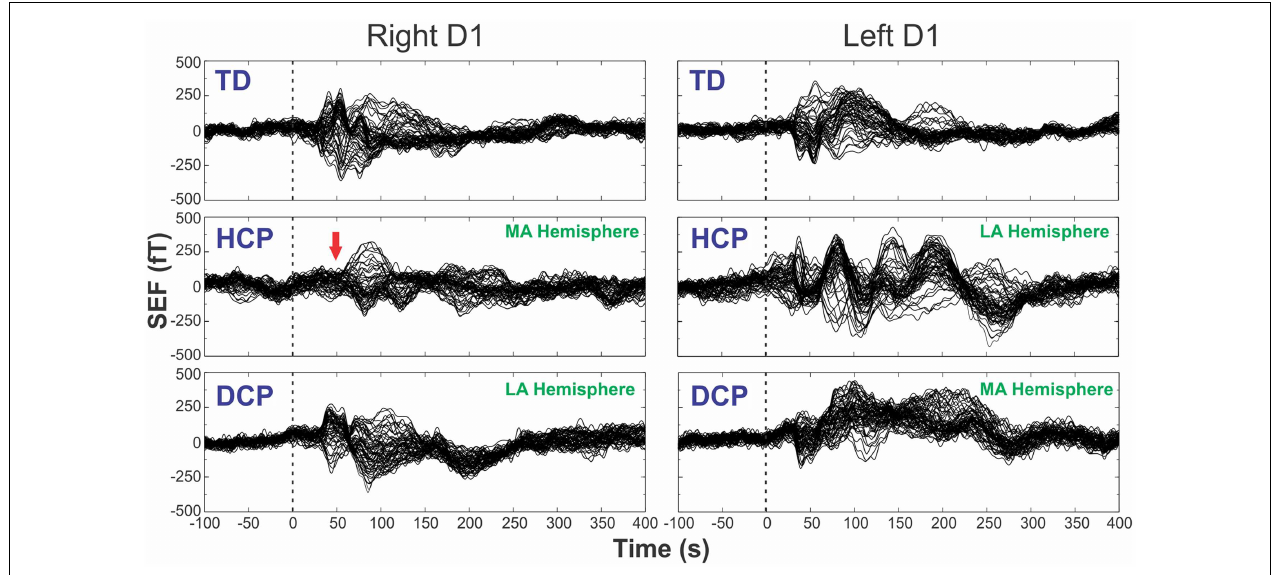
FIGURE 1 | SEFs evoked by the tactile stimulation of the right (left panels) and left (right panels) D1 fromTD2, HCP1, and DCP3 children from − 100 to 400ms after the stimulus onset . Red arrow indicates the absence of the first cortical response in the HCP1